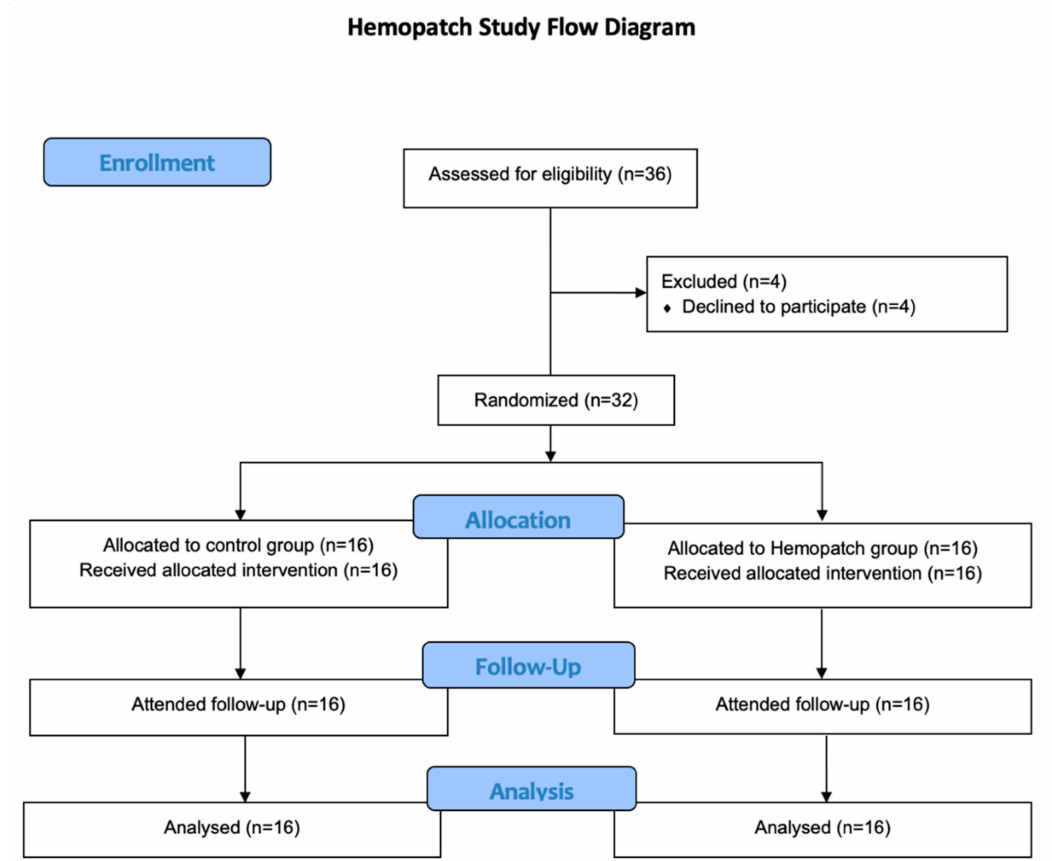
Figure 2. CONSORT flow